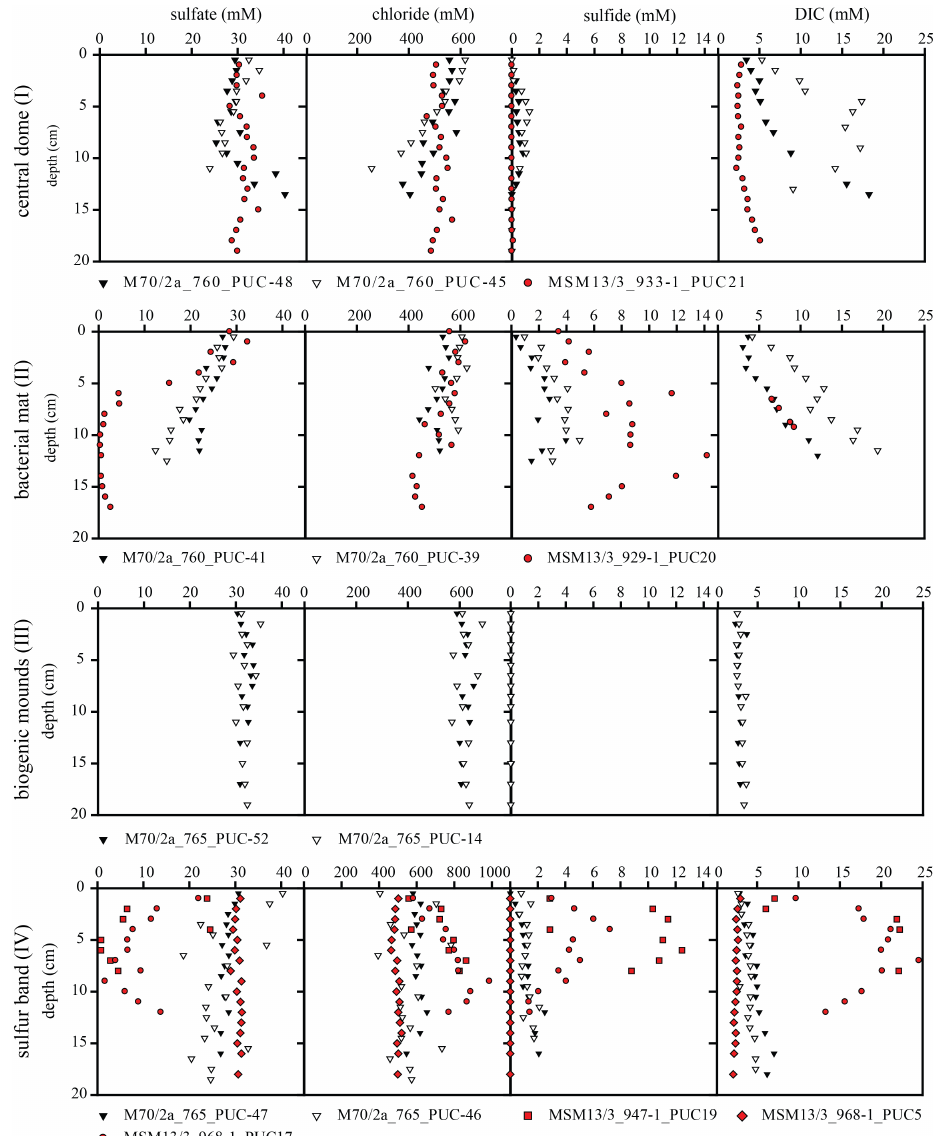
Fig. 3. Pore water data of sulfate, chloride, sulfide, and DIC (columns) from the four Amon MV habitats (rows): central dome (I), bacterial mat (II), biogenic mounds (III), and sulfur band (IV). The black and white symbols indicate replicate cores of the same station in 2006. Red symbols indicate pore water samples collected in 2009. Please note the different x scale of chloride in the lowest